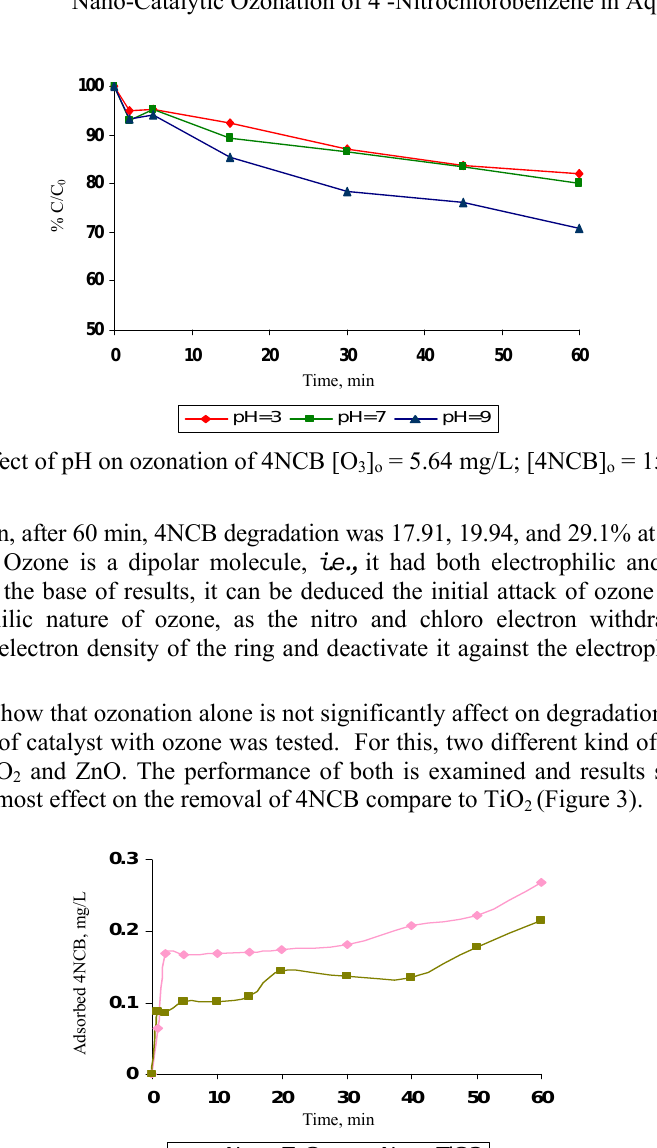
and ZnO [4NCB] =15 mg/L; [ZnO] =300 mg/L; [TiO2] 2 0 0